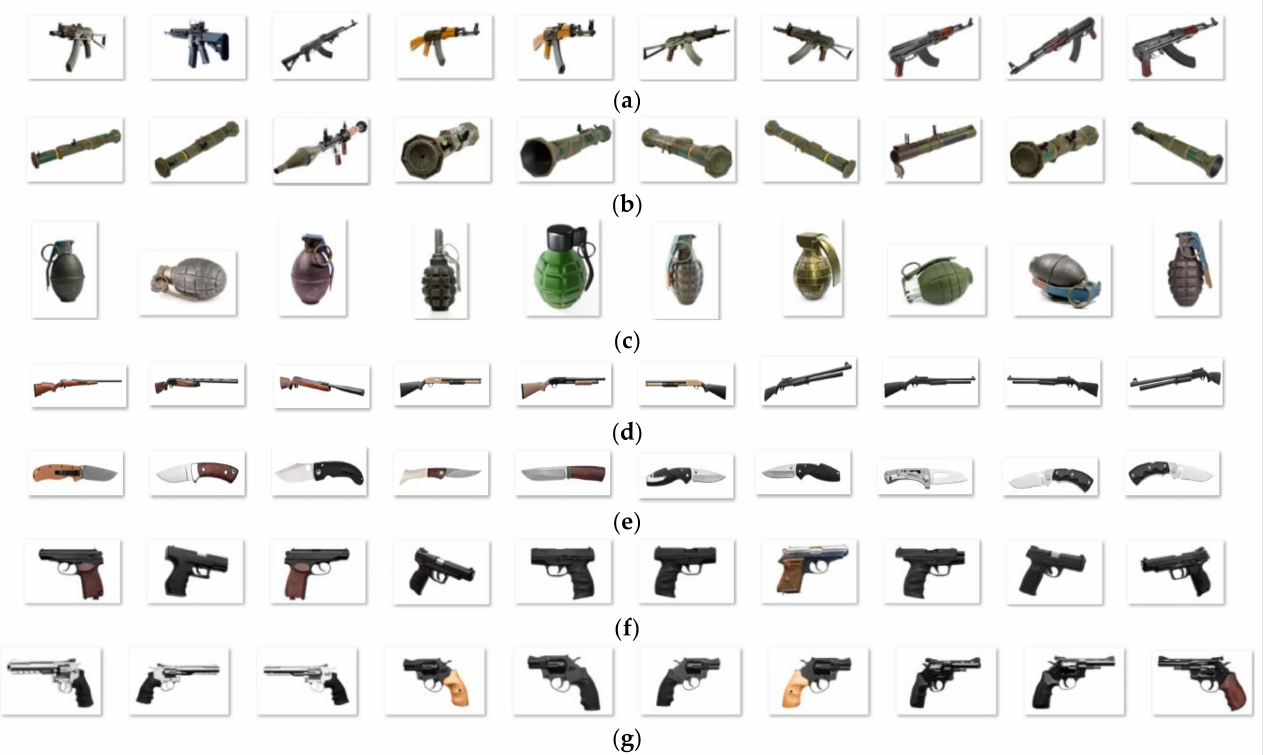
Figure 1. Sample dataset of different classes: ( a ) assault rifles; ( b ) bazookas; ( c ) grenades; ( d ) hunting rifles; ( e ) knives; ( f ) pistols; ( g ) revolvers.